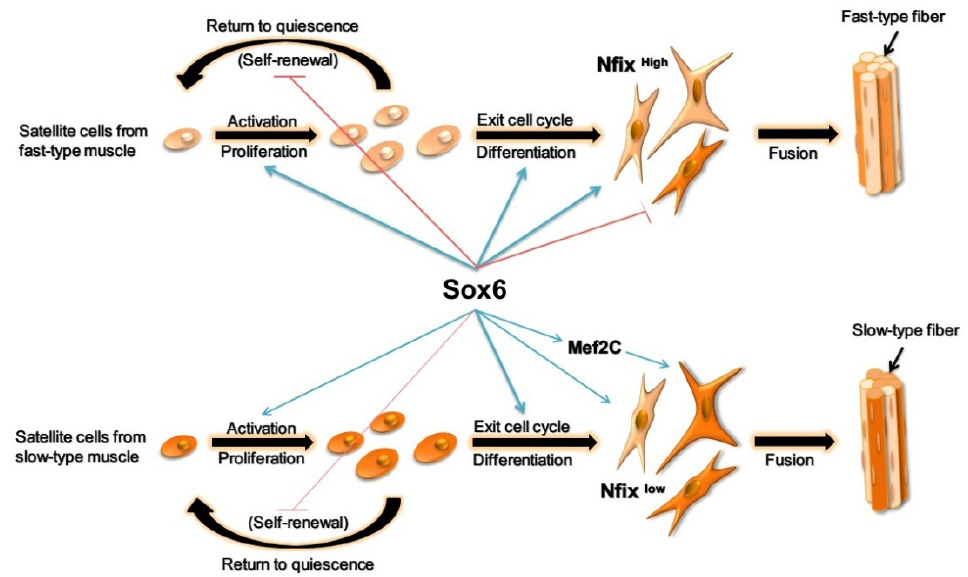
Figure 9. The regulation mechanism of Sox6 in satellite cells from fast-type and slow-type muscles. In brief, Sox6 promotes the proliferation and differentiation of PM-MBs and LM-MBs, improves the fast-type fiber formation. The upregulation of Nfix in PM-MTs inhibits the slow-type fiber formation via the collaboration with Sox6 . In LM-MTs, Sox6 activates Mef2C transcription to promote the slow-type fiber formation.